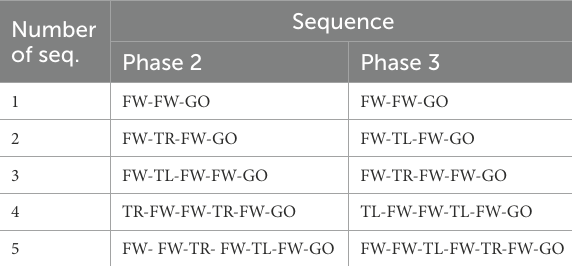
TABLE 5 Structure of complex sequences of commands. Number of